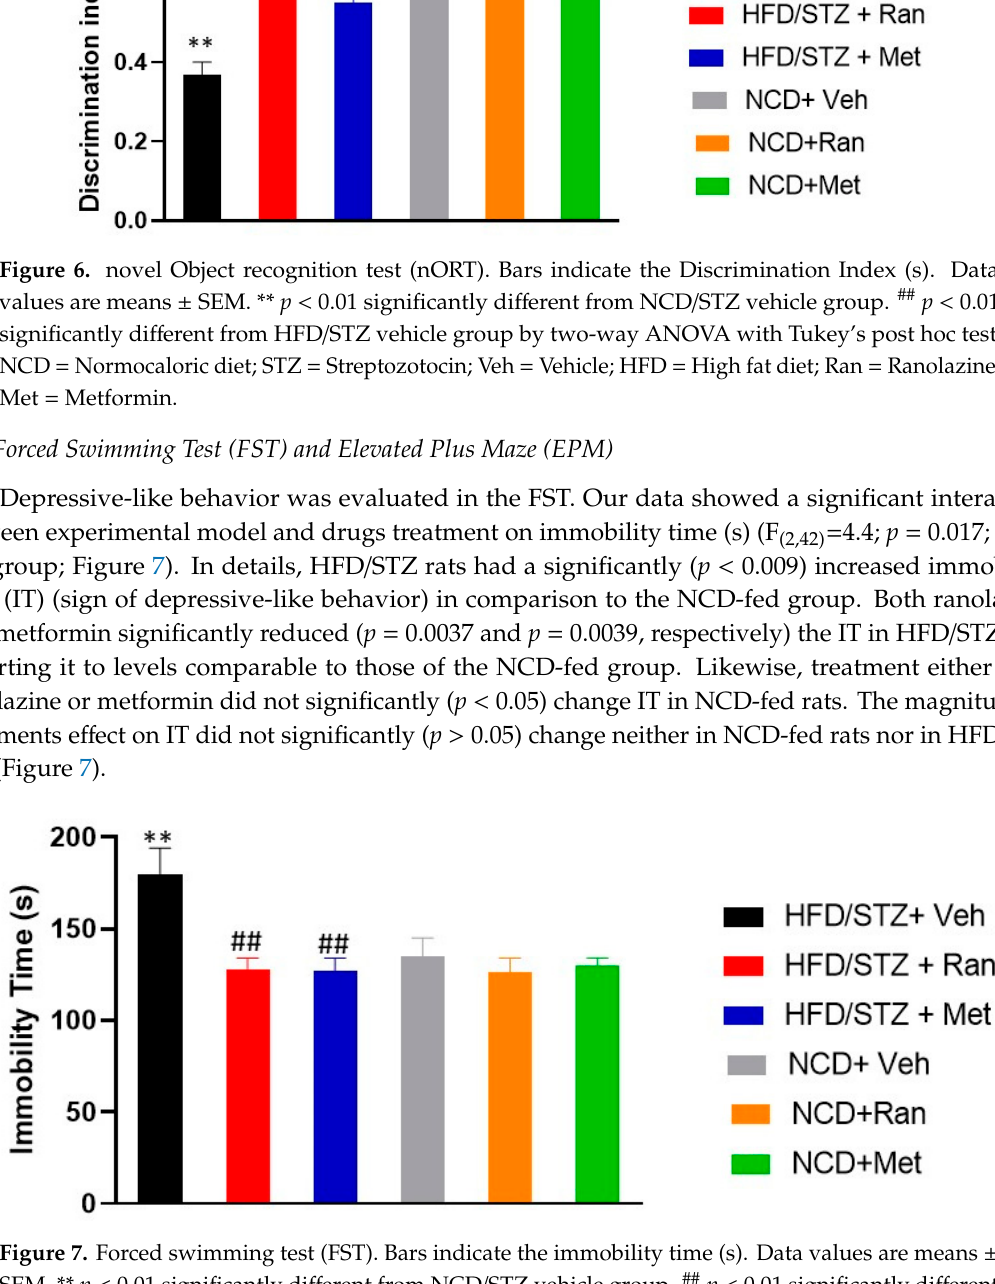
10 of 15 Figure 5. Passive avoidance test (PA). Bars indicate the latency (s) time to enter in the dark chamber during the retention session. Data values are means + SEM. *** p < 0.0001Significantly different from NCD/STZ vehicle group. ### p < 0.0001significantly different from HFD/STZ vehicle group by two- way ANOVA with Tukey’ s post hoc test. NCD = Normocaloric diet; STZ = Streptozotocin; Veh = Vehicle; HFD = High fat diet; Ran = Ranolazine; Met = Metformin. 3.4. Novel Object Recognition Test (nORT) The nORT was performed to study working-memory in each experimental group. No significant ( p > 0.05) difference was found among experimental groups in the ability to reach 20s of exploration in the familiarization trial. At odds, data showed a significant interaction between experimental model and drugs treatment on Discrimination Index (DI) (F (2,42) = 4.64; p = 0.015; n = 8 per group; Figure 6). In details, HFD/STZ rats had a significant ( p = 0.004) reduction of DI in comparison to NCD- fed group, suggesting a working memory impairment. Interestingly, treatment either with ranolazine or metformin was able to induce a significant ( p = 0.001 and p = 0.003, respectively) increase of DI in HFD/STZ rats, rescuing the observed memory impairment. Additionally, there was no significant ( p > 0.05) difference between the magnitude of effect of the two treatments on DI in HFD/STZ rats. Likewise, treatment either with ranolazine or metformin did not significantly ( p < 0.05) change